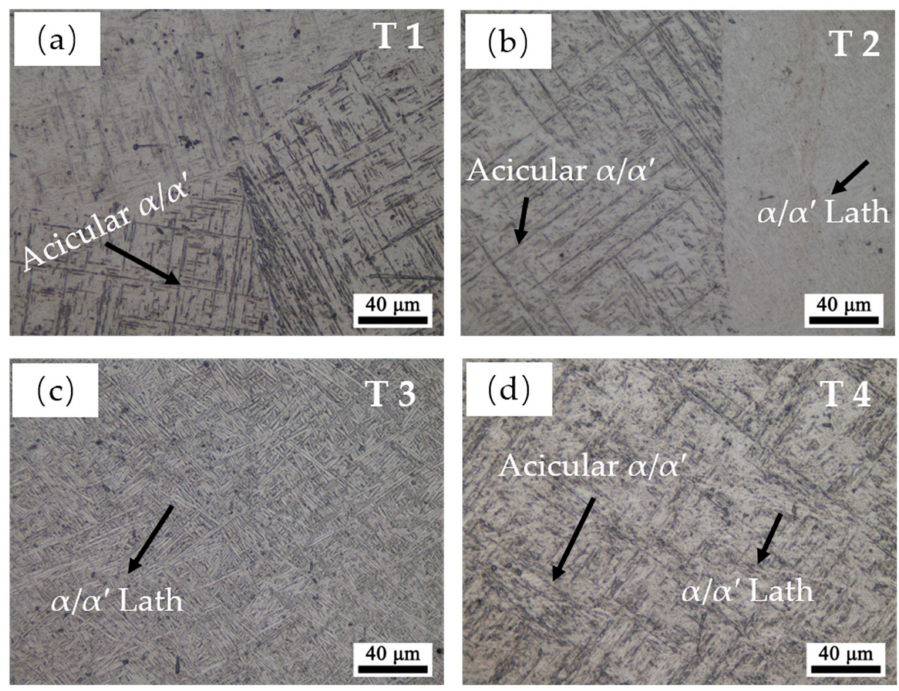
Figure 7. The magnification micro-structure image in the traverse plane of sample: ( a ) T1, ( b ) T2, ( c ) T3, and ( d ) T4.